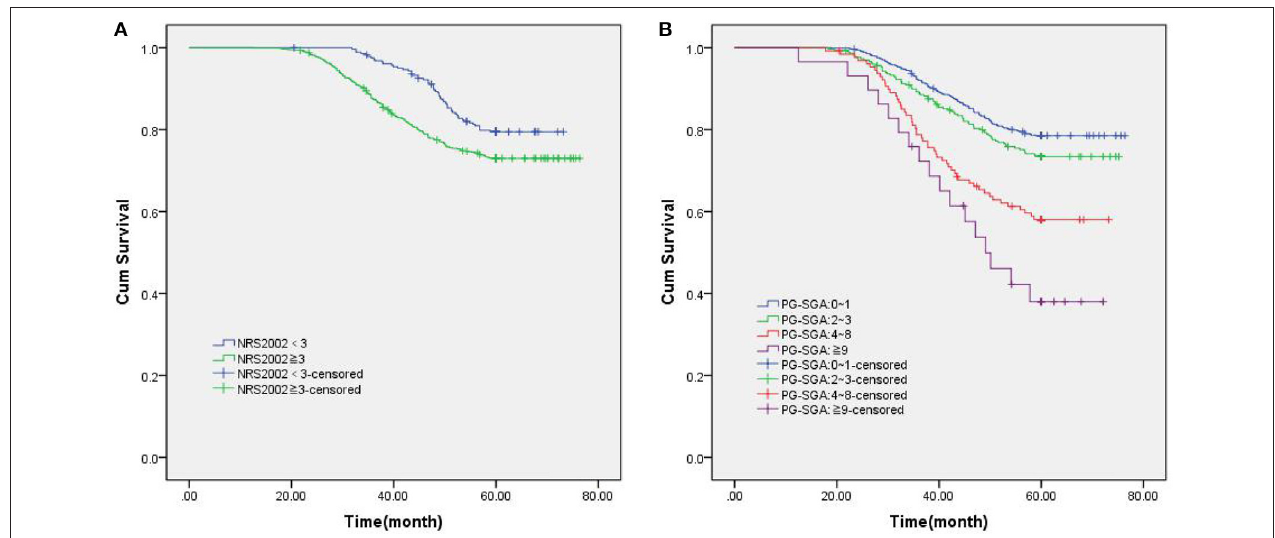
FIGURE 2 | Kaplan-Meier survival curves in patients with newly diagnosed GIST patients. (A) Overall survival based on NRS2002 scores; (B) Overall survival based on PG-SGA